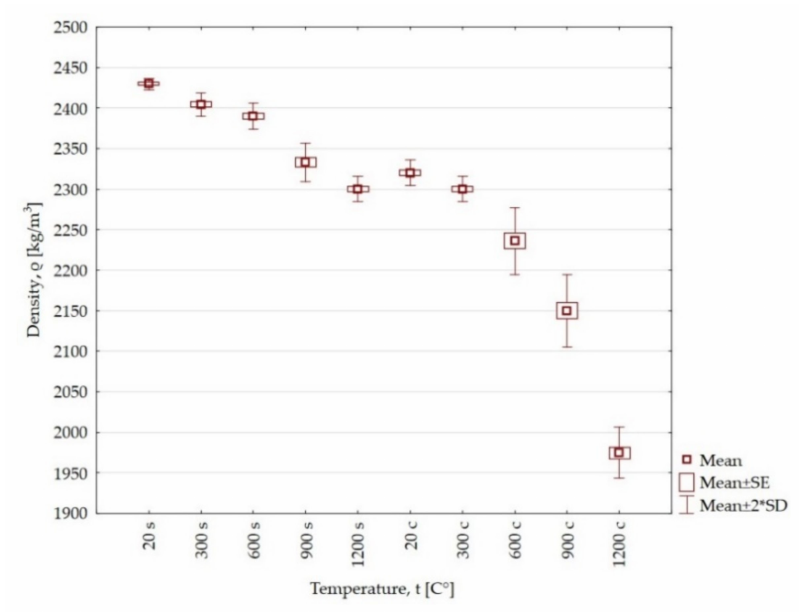
Figure 10. The influence of high temperature on the weight loss for sandstone and claystone samples: s—sandstone; c—claystone; SE—standard error; SD—standard deviation. The average compressive strength of sandstone samples at 20 ◦ C was 61.2